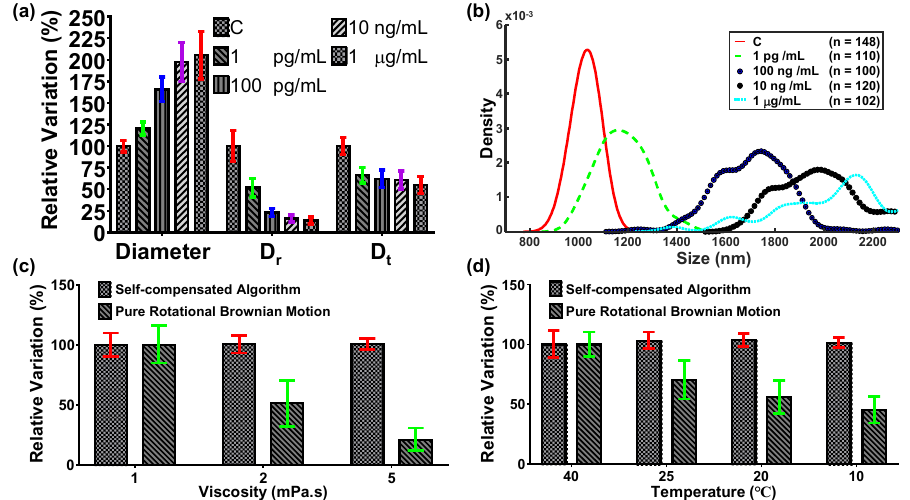
Figure 7. Experimental results. ( a , b ) The relative percentage of particle diameter, D r , and D t , and KDE distribution of particles under different concentrations of glycerol. D r and D t decreased with the increase of glycerol concentration. The viscosity was inversely proportional to D r and D t . ( c , d ) The relative particle diameter, D r , and D t , and KDE distribution under different temperatures. D r and D t decreased with the decrease of temperature. The temperature was proportional to D r and D t .